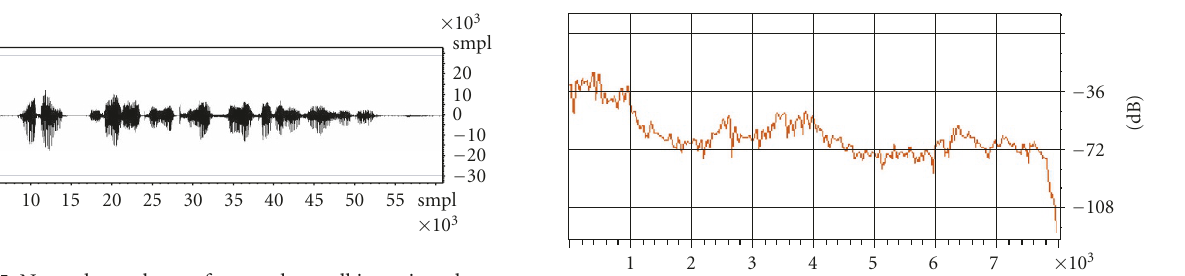
Figure 15: Normal speech waveform—close-talking microphone.